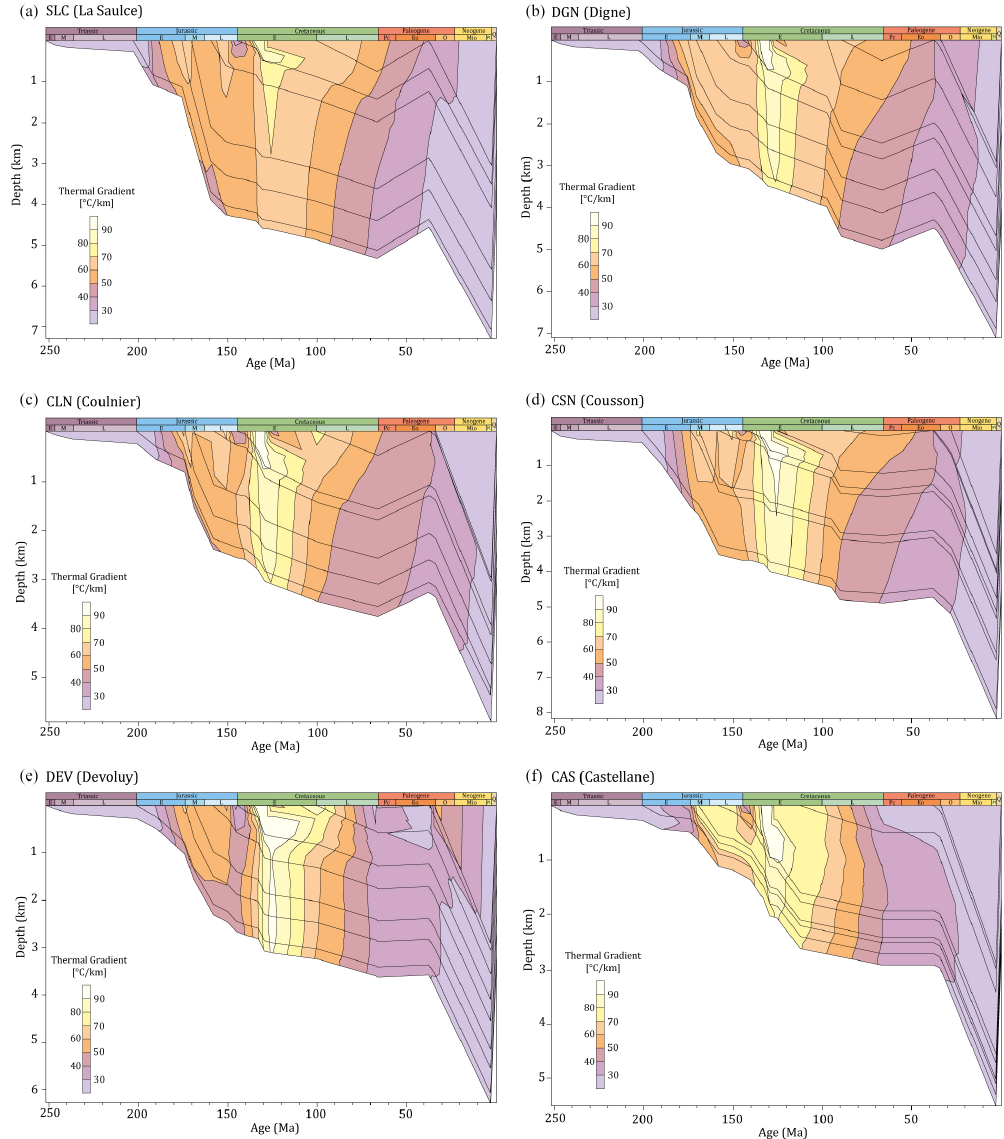
Figure 6. Burial evolution of each sedimentary column and evolution of geothermal gradients along the sections for the Two-rifts model.